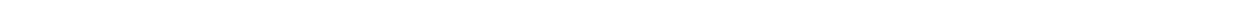
Fig. 10 Crosstalk between SUMOylation and PKC phosphorylation of TRPV1. a CHO-K1 cells were transfected with Flag-TRPV1 and its mutants together or not with GFP-SUMO1 or RGS-SENP1 as indicated. Cell lysates were subjected to IP by anti-Flag, followed by IB for GFP, Flag, and RGS. b CHO-K1 cells transfected with Flag-TRPV1, GFP-SUMO1, and RGS-SENP1 were untreated or treated with PMA (1 μ M, 15 min) as indicated. Cell lysates were subjected to IP by anti-Flag, followed by IB for GFP, Flag, and RGS. c CHO-K1 cells transfected with Flag-TRPV1 and Flag-TRPV1-K822R were untreated or treated with PMA as indicated. To enhance the sensitivity, TRPV1 was enriched by IP using the anti-Flag antibody before IB was performed using the anti-phospho- S800 TRPV1 antibody (p-S800). *** P < 0.0001 for TRPV1 vs. TRPV1 K822R; TRPV1 vs. TRPV1 + PMA; and TRPV1 + PMA vs. TRPV1 K822R + PMA. d CHO- K1 cells transfected with Flag-TRPV1, GFP-SUMO1, and RGS-SENP1 were untreated or treated with PMA as indicated. The levels of phospho-S800 TRPV1 were determined as in c . Quanti fi cations (means ± s.e.m.) of TRPV1 SUMOylation based on the results of IP Flag/IB GFP ( a , b ) and S800 phosphorylation based on the results of IP Flag/IB p-S800 ( c , d ) from three independent experiments are shown below the representative blots. e SUMOylation, but not PKC phosphorylation, at S502/S800 of TRPV1 is essential for in fl ammatory thermal hyperalgesia. Similar to Fig. 9f, but the left L3 – L4 DRG of TRPV1 − / − mice were injected with AAV-TRPV1-S502/800A ( n = 6) or AAV-TRPV1-S502/800A/K822R ( n = 6). The mice were subject to the carrageenan edema model at 4 weeks after the injection. The paw withdrawal latency was measured by Hargreaves test. AAV-TRPV1-S502/800A, but not AAV-TRPV1-S502/ 800A/K822R, rescued thermal hyperalgesia. *** P < 0.0001 for AAV-TRPV1-S502/800A vs. AAV-TRPV1-S502/800A/K822R. Data are means ± s.e.m. Student ’ s t test for c and d , two-way ANOVA for